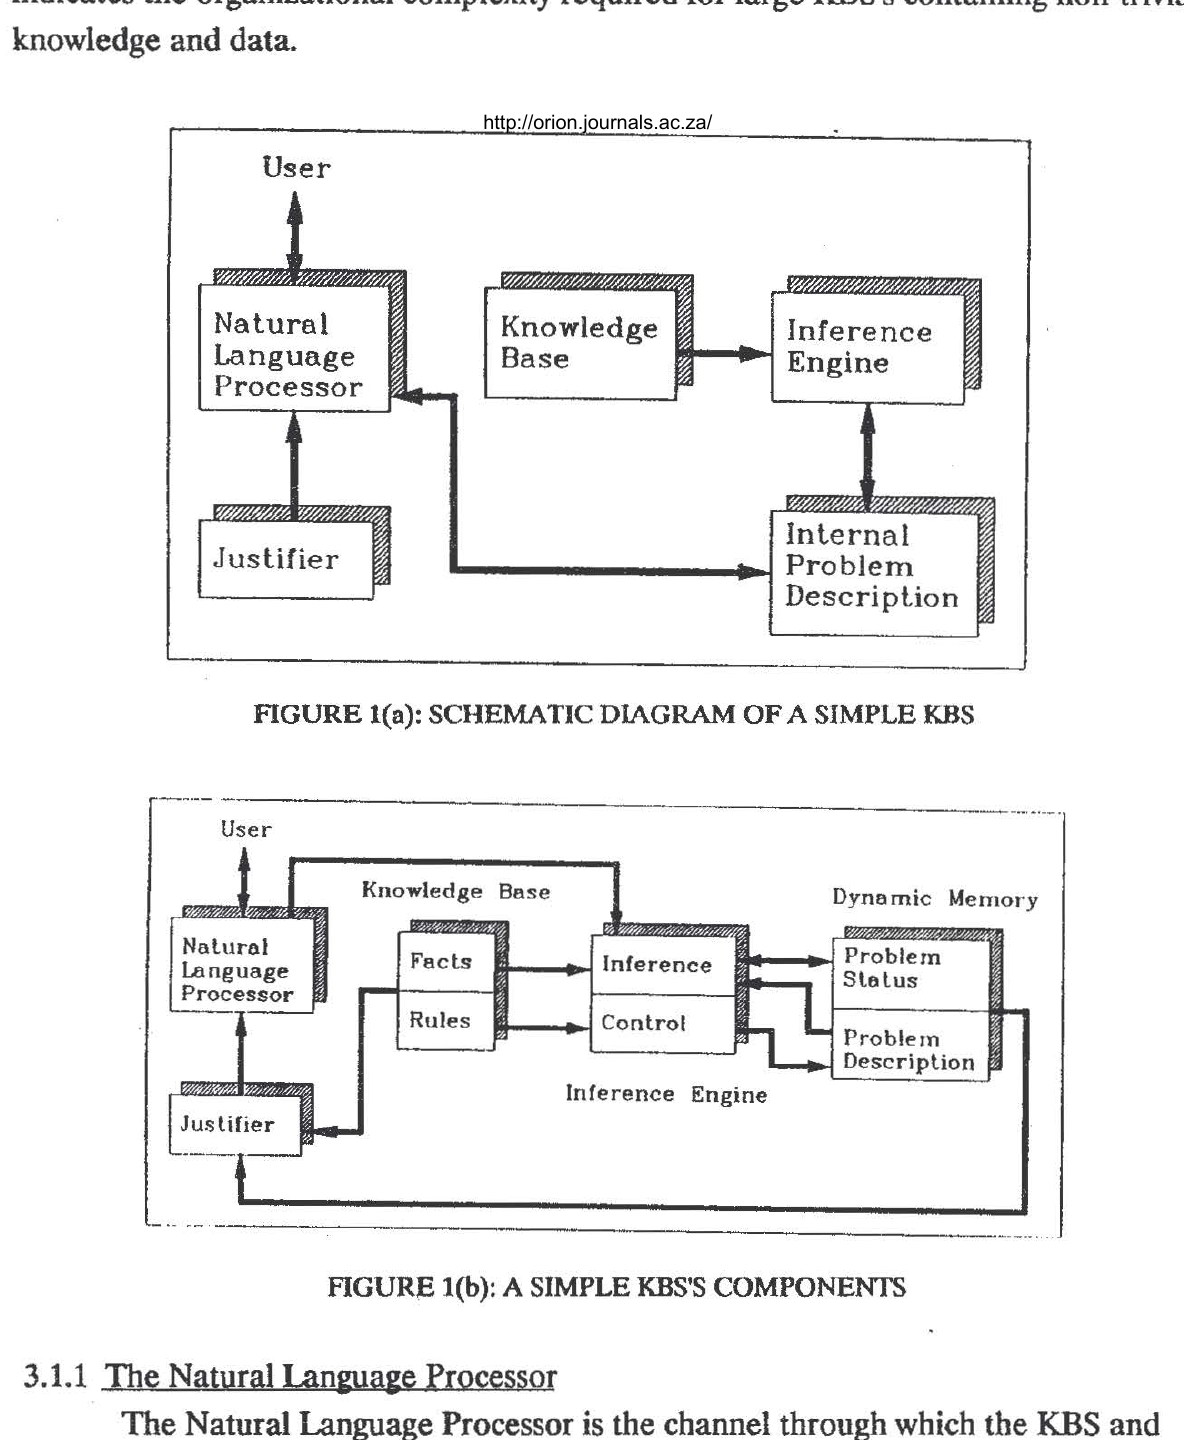
FIGURE l(a): SCHEMATIC DIAGRAM OF A SIMPLE